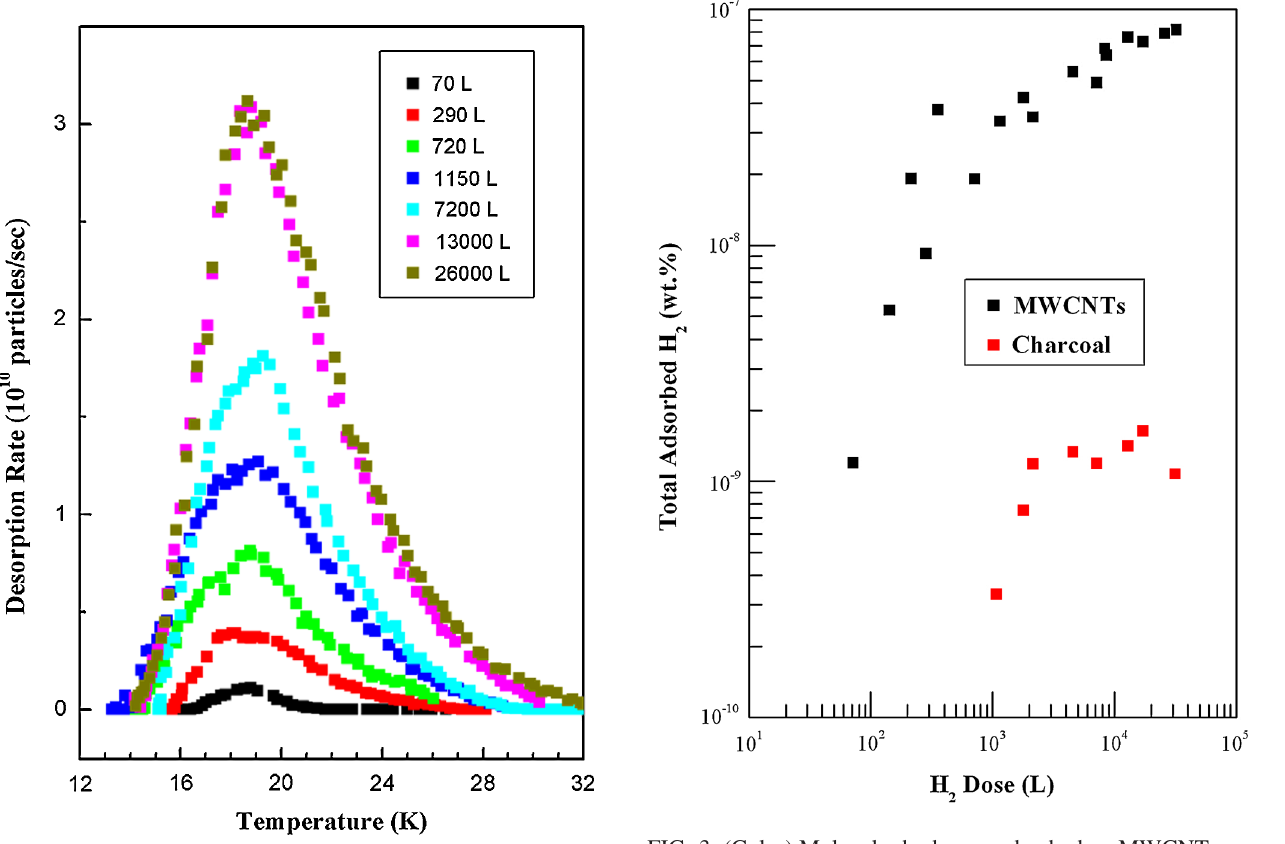
FIG. 2. (Color) Temperature programmed desorption traces of molecular hydrogen adsorbed at T 2 (cid:1) 10 (cid:2) 5 Torr . The dose is expressed in Langmuir ( 1 L ¼ 10 6 Torr sec ).